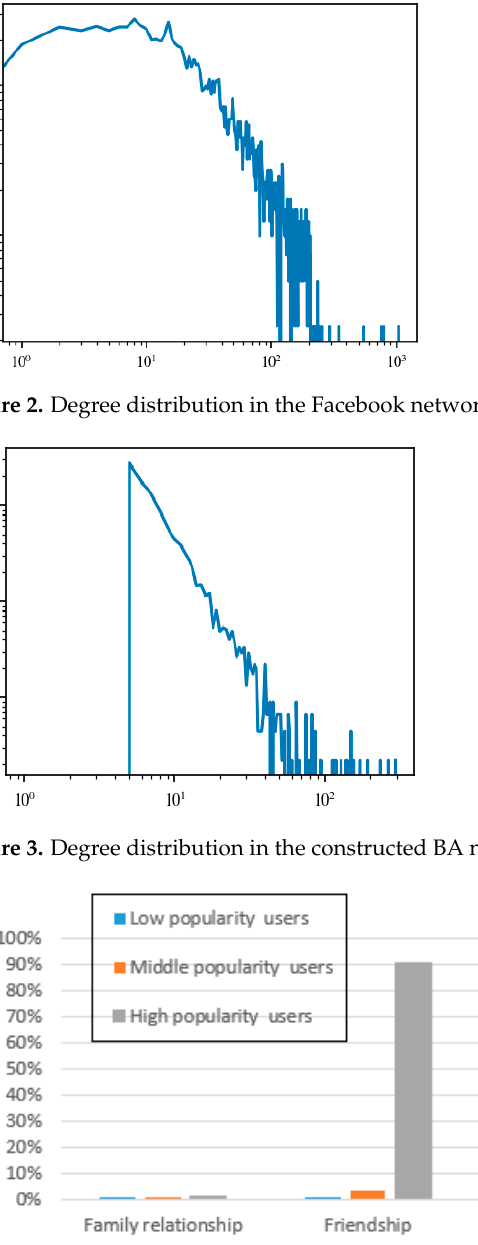
Table 3. Proportion of intimacy and distribution of value range.